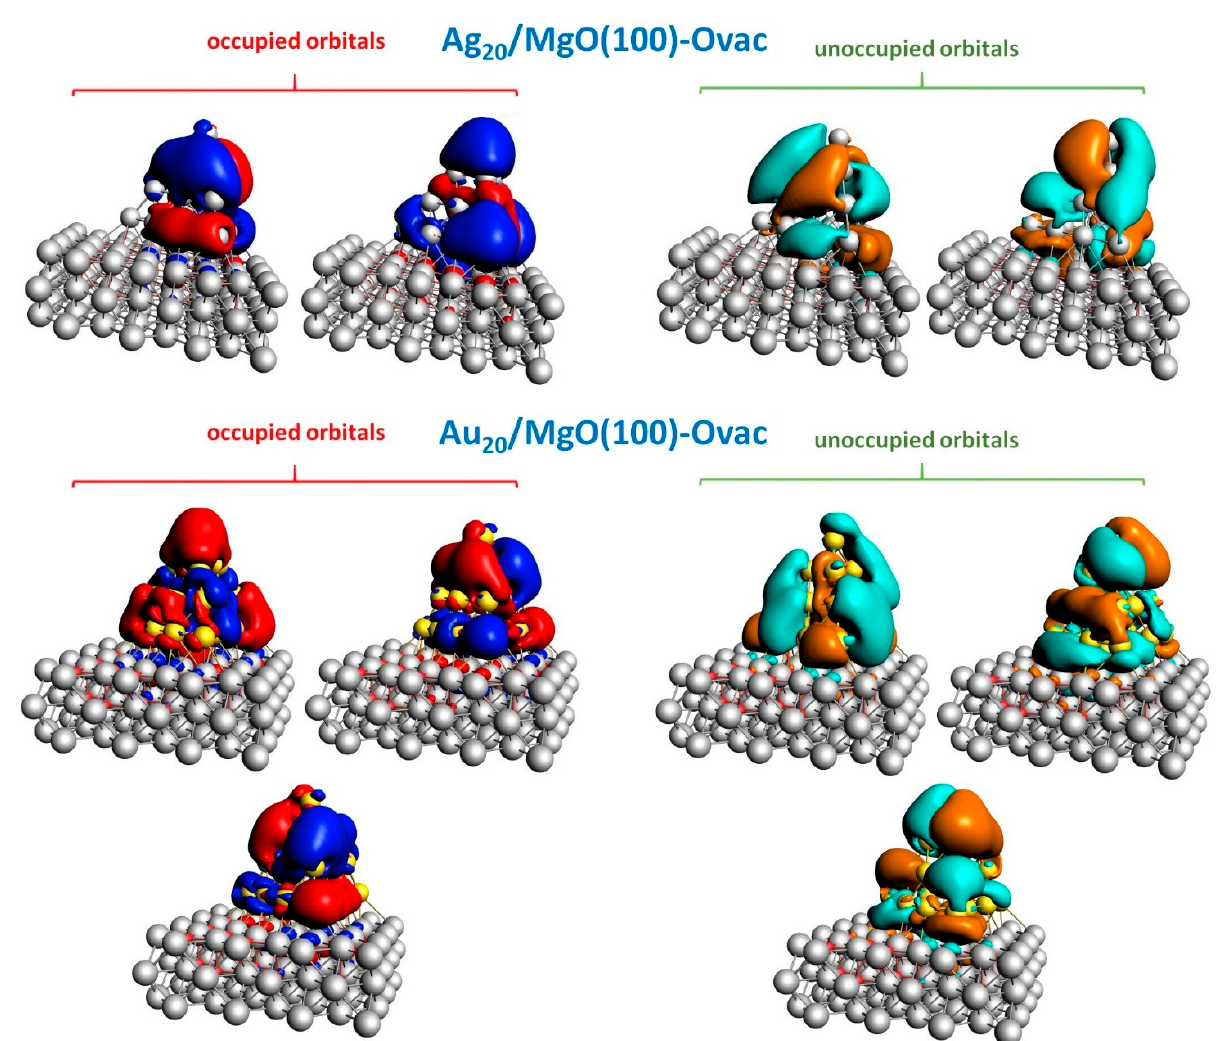
Figure 7. Contour plots of the Molecular Orbitals (MOs) of Ag 20 /MgO(100)-Ovac ( top-most row ) and Au 20 /MgO(100)-Ovac ( bottom two rows ) systems simulated using the ADF code. MO energy increases from left to right and (for the Au 20 case) from top to bottom. Isosurfaces are set to contour values of 0.01 Å − 3/2 .